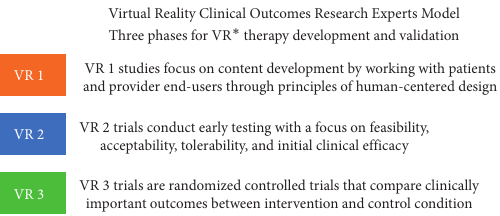
Figure 1: Summary of stages for the development and validation of VR-based therapies (https://www.ncbi.nlm.nih.gov/pmc/articles/ PMC6374734/?report �